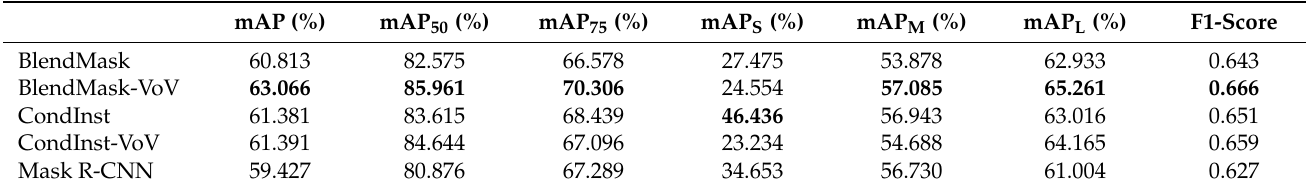
Table 4. Quantitative Evaluation of the test set in the bounding box detection task.